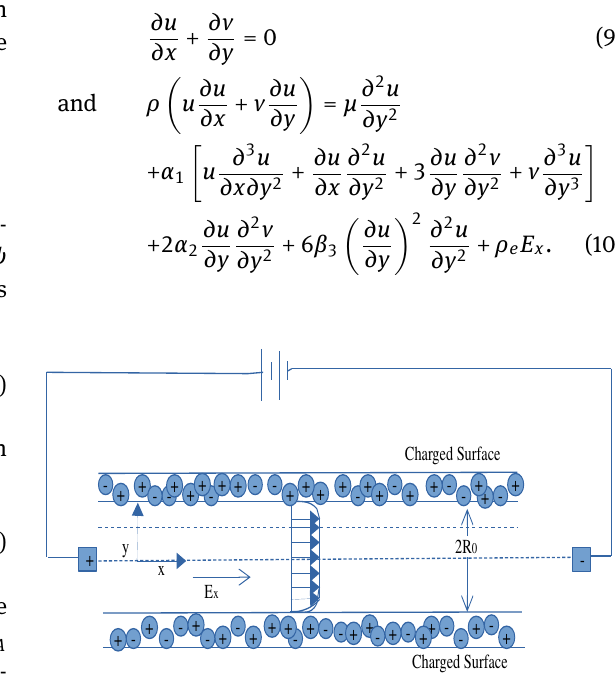
Fig. 1: Sketch of the